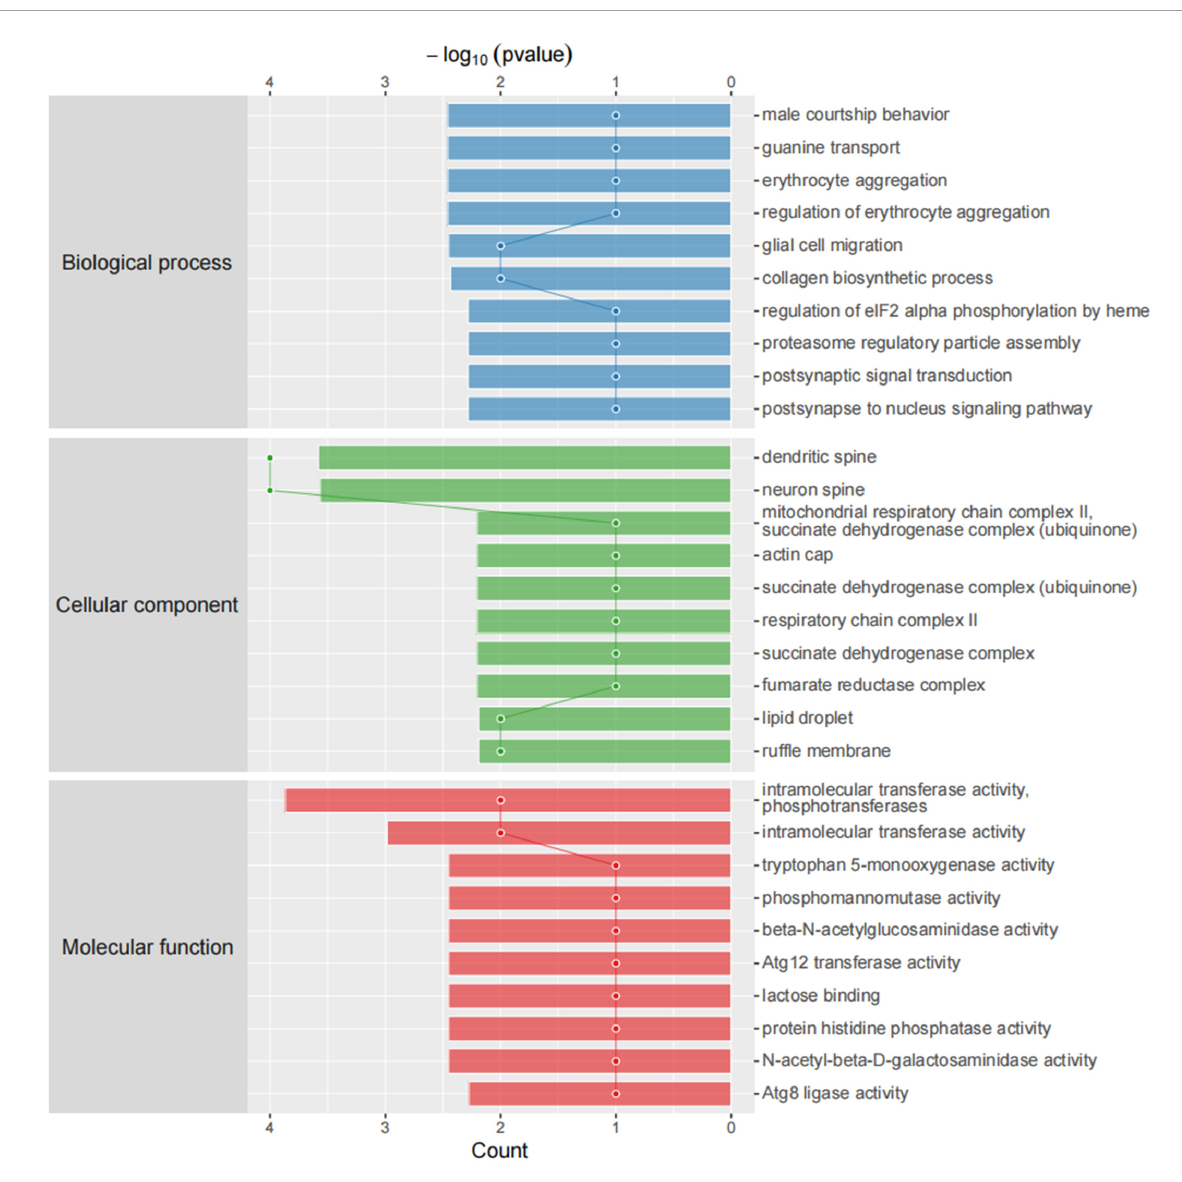
FIGURE7 Gene ontology (GO) cellular components. Top axis is -log10 ( p -values) and bottom axis is gene count. The ontology covers three domains: biological process, cellular component, and molecular